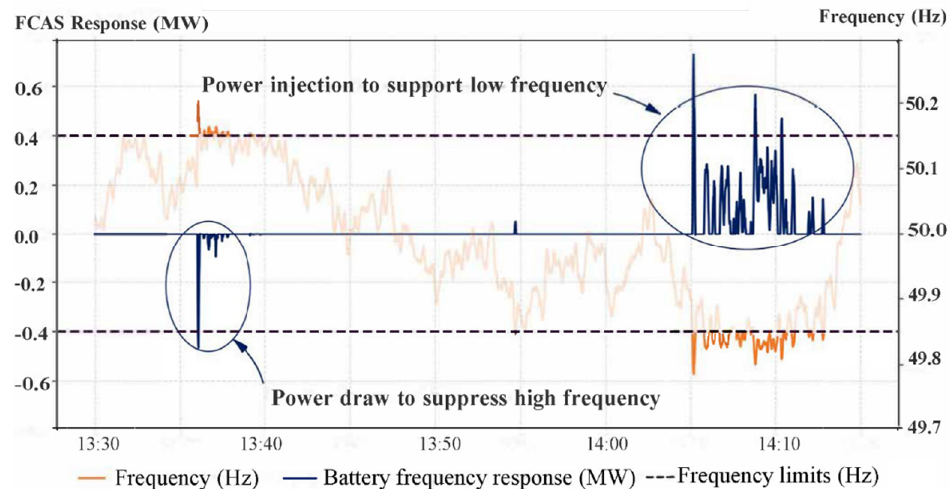
Figure 5. Battery contingency FCAS response—10 December 2019 (Victoria and South Australia re-